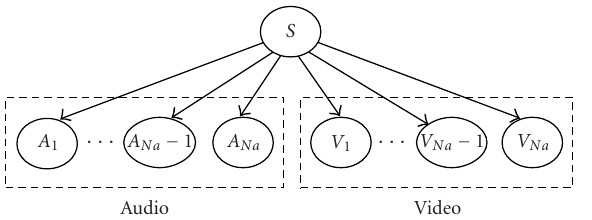
Figure 3: Bayesian network for fusing audio and video